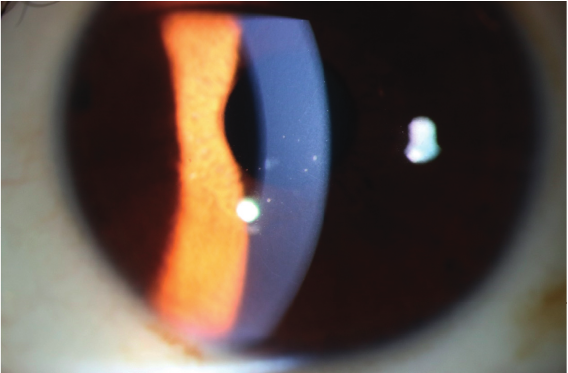
Figure 2: Mutton-fat KP under a slit lamp. Color photograph of the left eye of a 40-year-old male patient shows typical mutton-fat KP under a slit lamp. Several mutton-fat KPs can be seen in the middle and lower